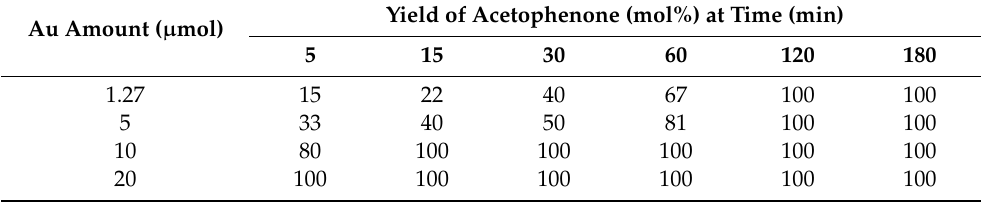
Table 3. E ff ect of the total gold amount on the peroxidative oxidation of 1-phenylethanol 1 using 4% Au / La 2 O 3 / TiO 2 _O 2 . Yield of Acetophenone (mol%) at Time (min) Au Amount ( µ mol)